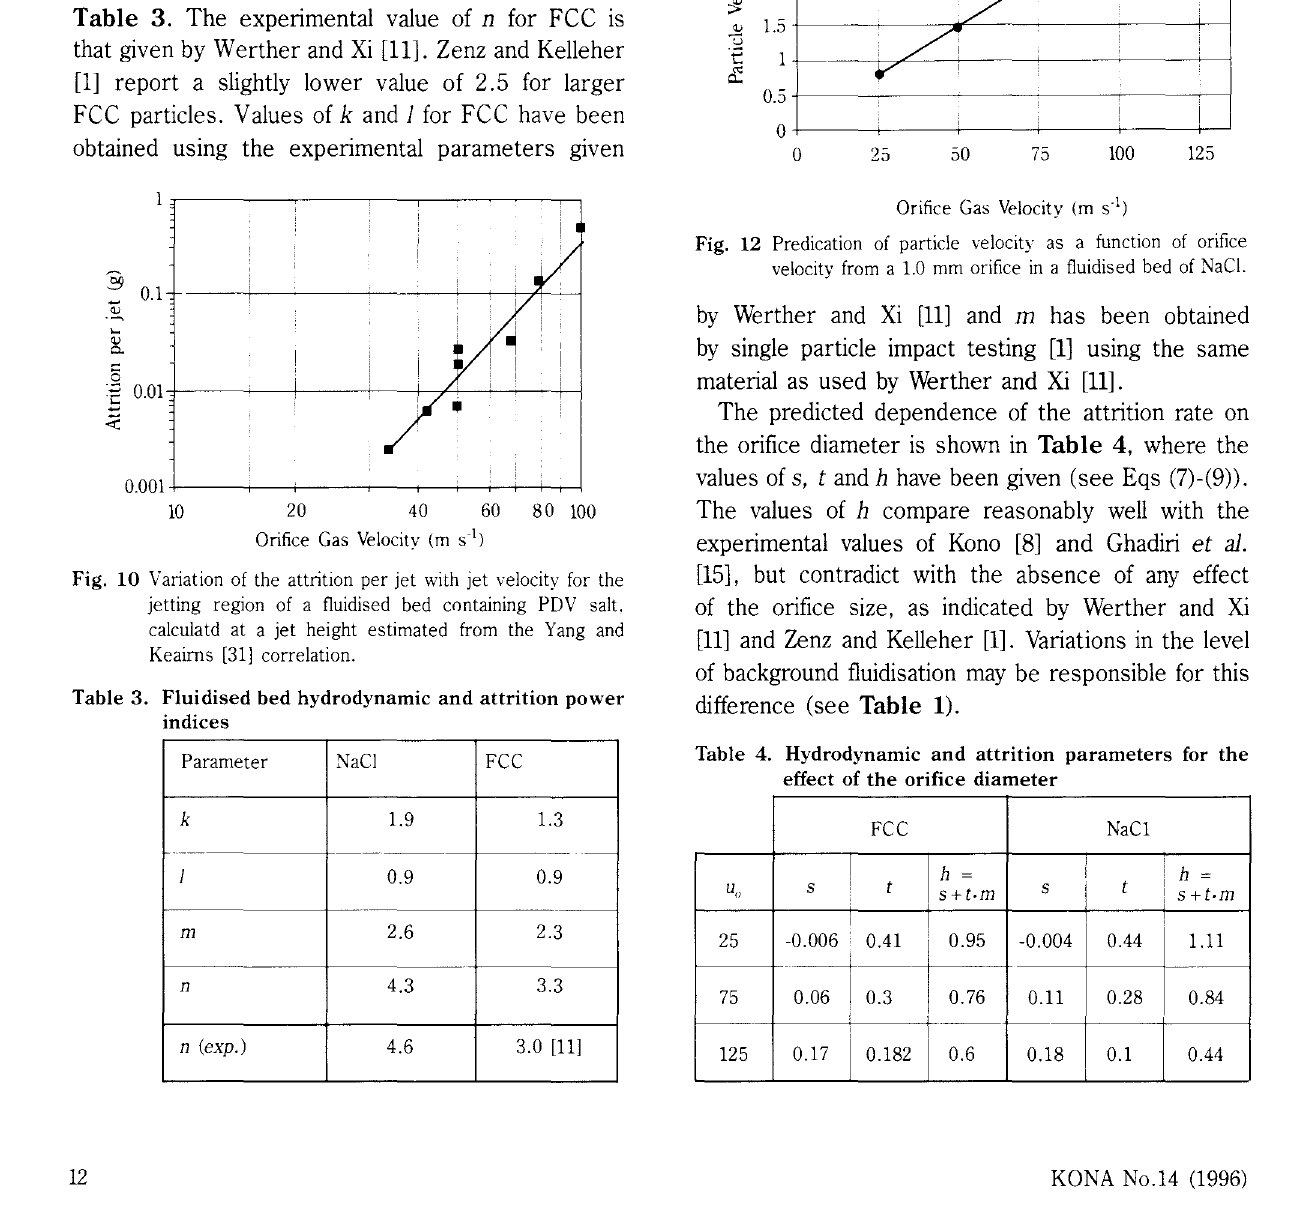
Fig. 11 Predicted variation of the solids entrainment rate W, in a fluidised bed of NaCI with the orifice gas velocity from a 1.0 mm orifice.